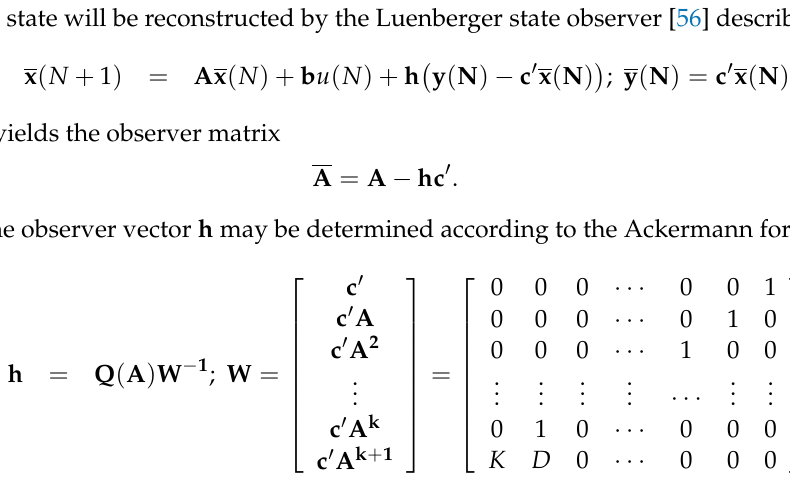
Figure 2. Plant model with a piecewise constant input disturbance d i (changed by uncontrolled input pulses u d (cid:54) = 0) and the output delay consisting of k shift